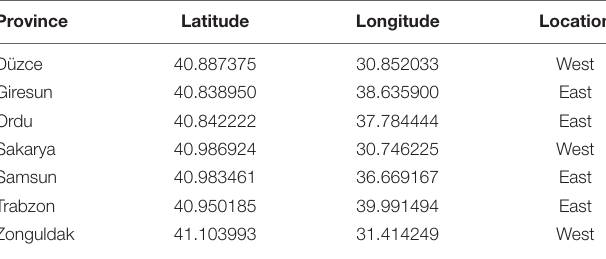
TABLE 1 | Wireless weather station GPS coordinates of Turkish provinces selected for the study.